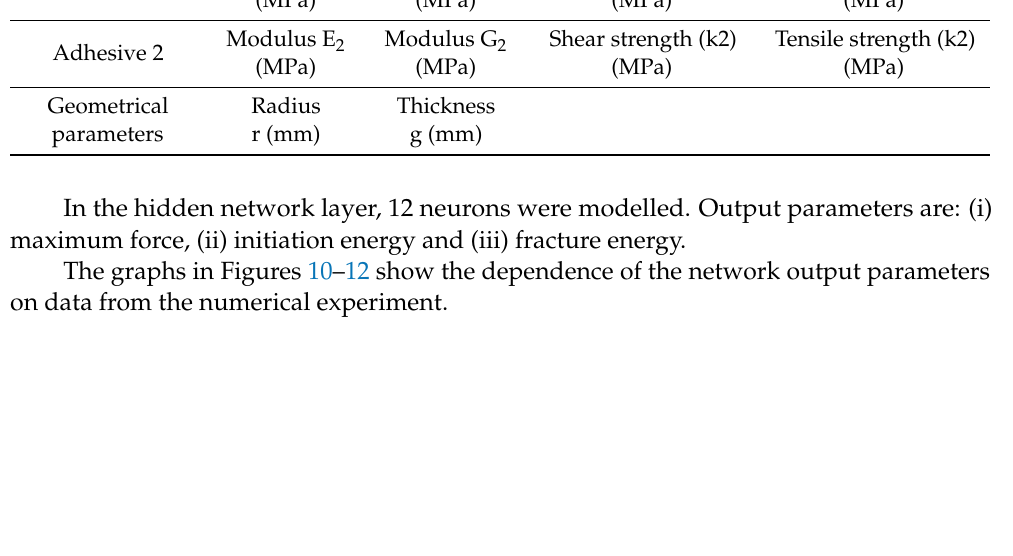
Table 2. Neural network input parameters.